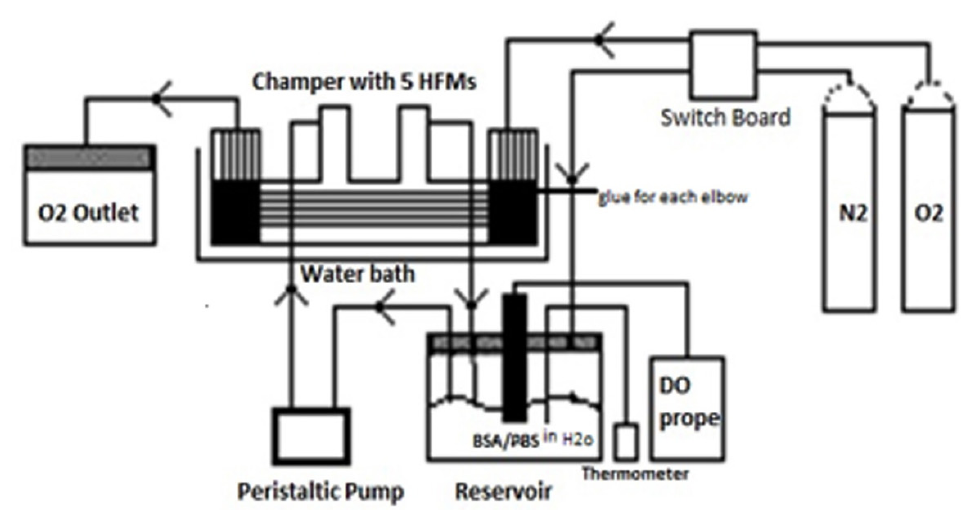
Figure 1. Diagram of a new design of gas exchange module for measuring O 2 rates of unmodified and modified HFMS.